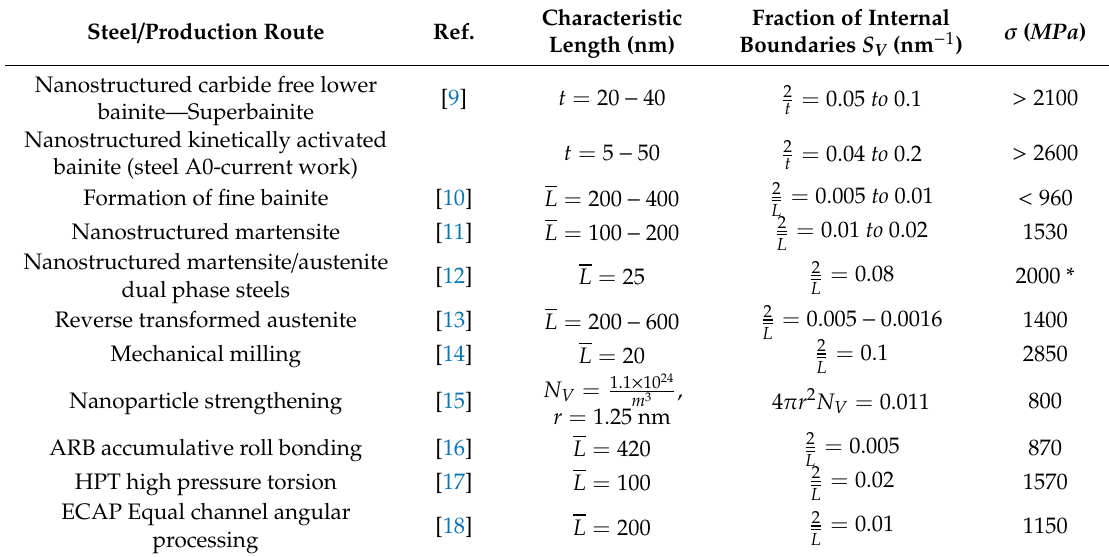
Table 1. Strengthening mechanisms in di ff erent steels, partially adapted from